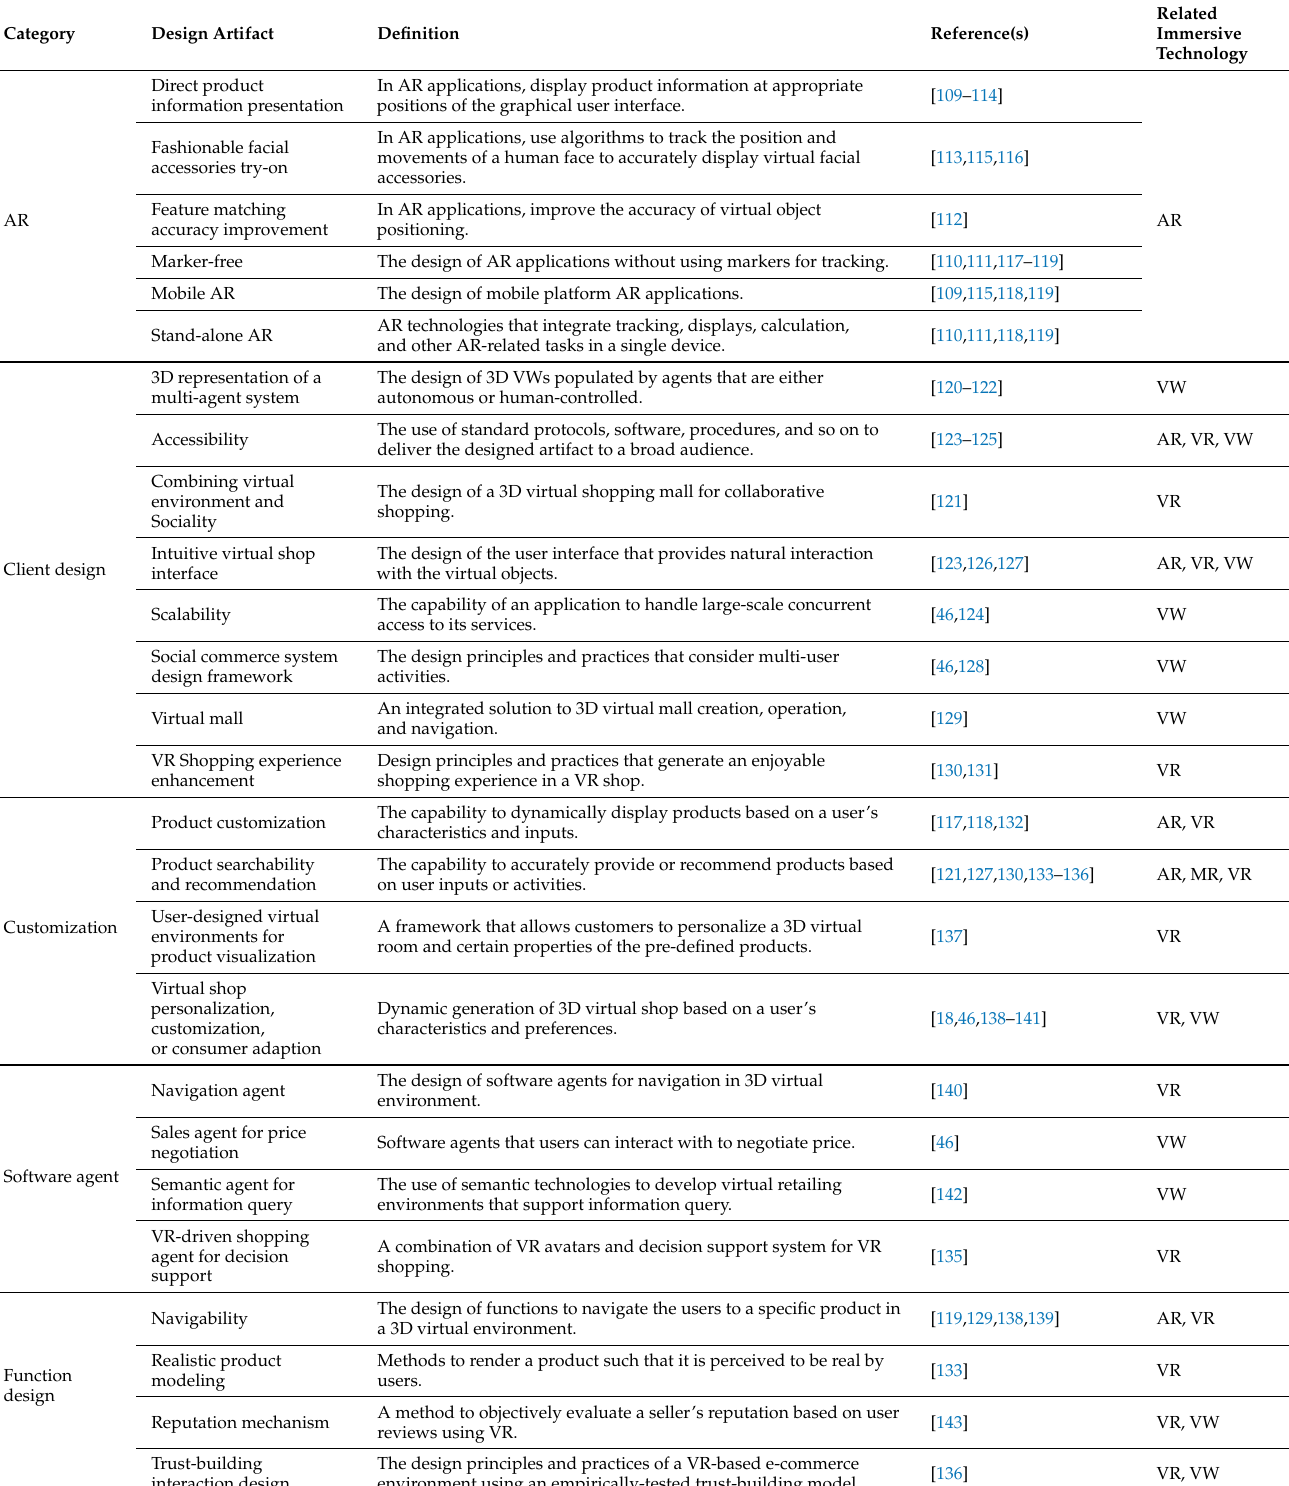
Table 8. Design artifacts of virtual commerce